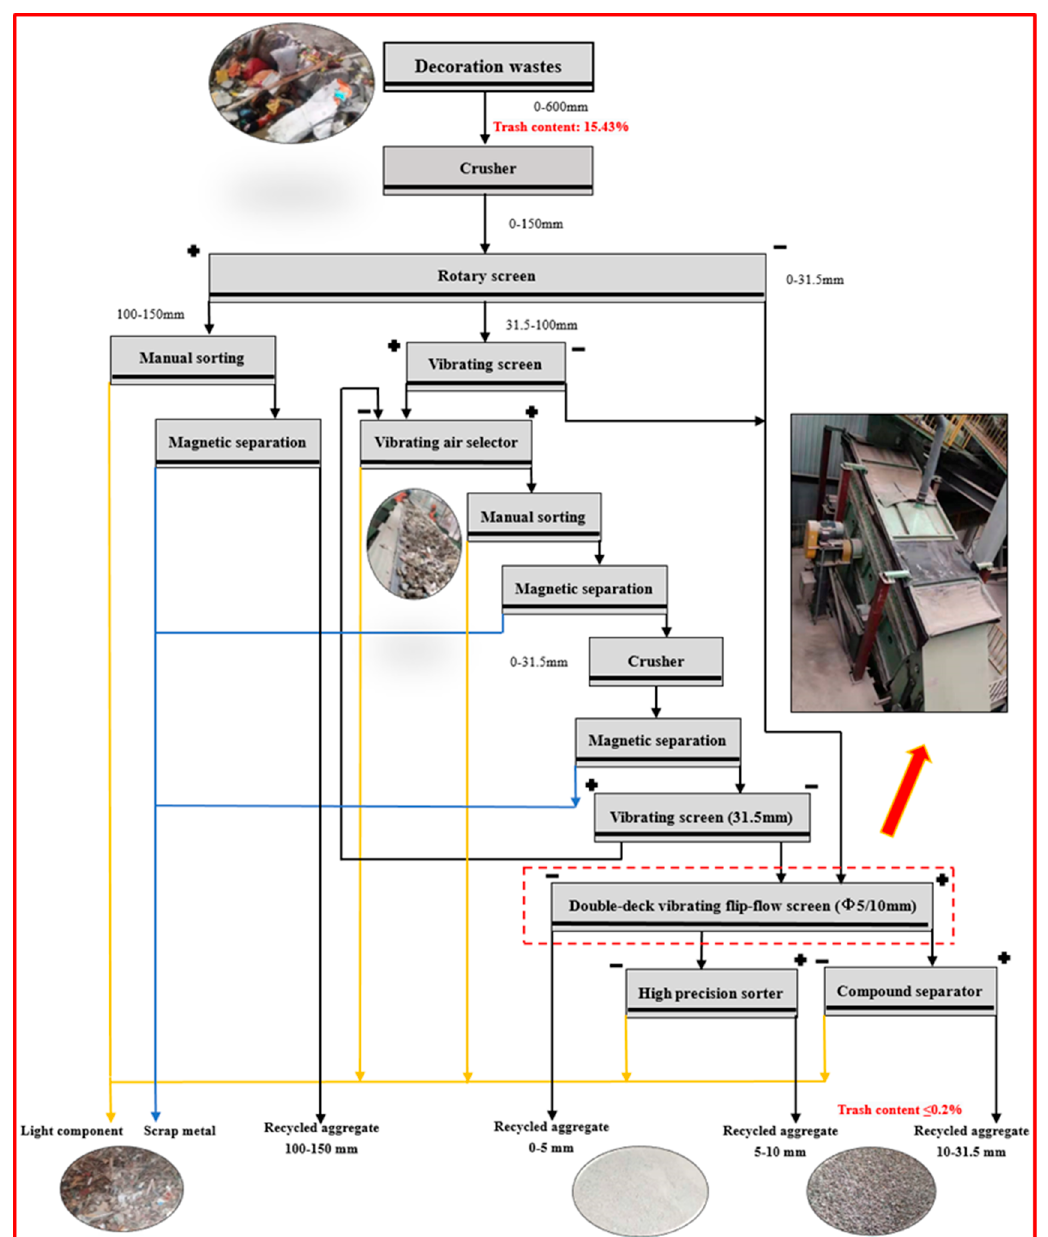
Figure 1. Double–deck flip–flow screen in the decoration of waste recycling application.